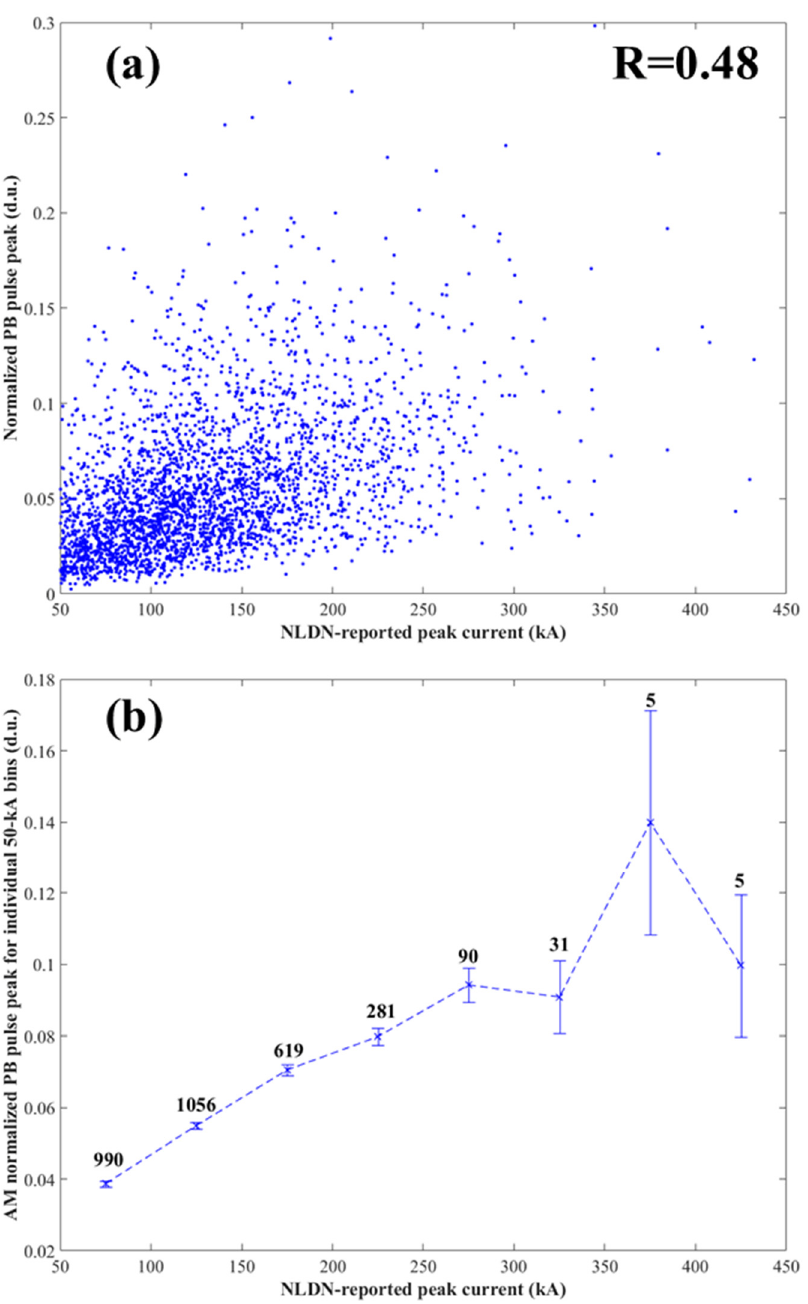
Figure 10. ( a ) Scatterplot of the peak of the largest PB pulse normalized to 100 km (in digitizer units) versus NLDN-reported RS peak current for the 3077 negative first strokes within 50 to 500 km of LOG. R is the Spearman correlation coefficient; ( b ) AM values of normalized PB pulse peak for individual 50-kA bins versus NLDN-reported RS peak current. The standard errors in mean values are shown by vertical bars and the corresponding sample sizes are given above them.